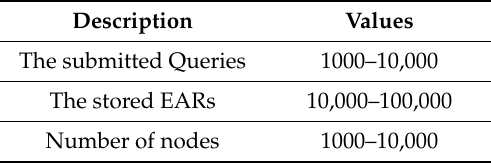
Table 3. Parameters used in the experiments.